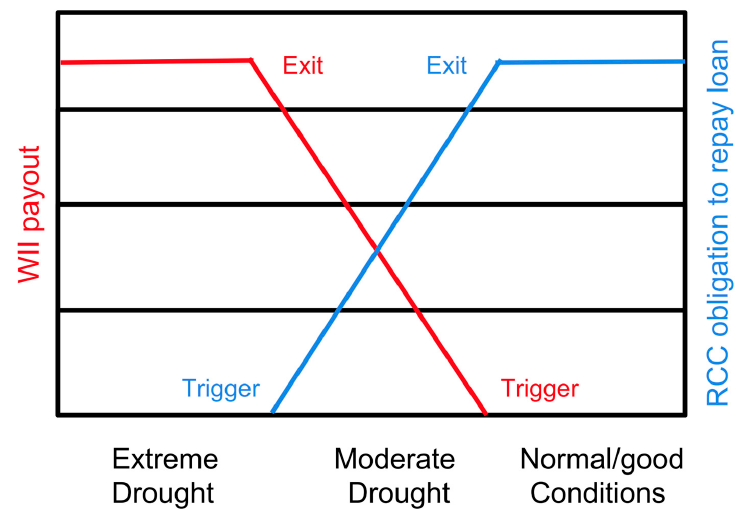
Figure 1. Simplified schematic illustration of weather index insurance (WII) (red) and risk contingency credit (RCC) (blue) concepts for agricultural drought. In the case of WII, the trigger represents the linear increase of payouts up to a predefined maximum payout (exit); In the case of RCC, the trigger represents a linear increase in the obligation to repay a loan up to a predefined maximum percentage.